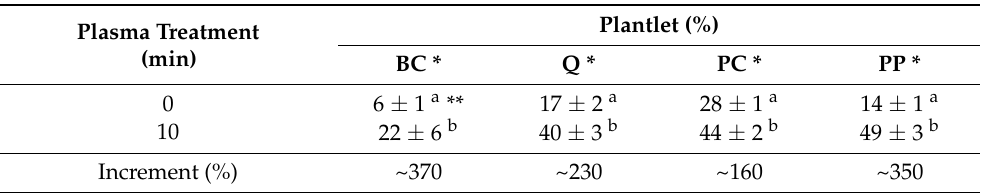
Table 4. The effect of plasma treatment on synseed germination and plantlet development of different chrysanthemum